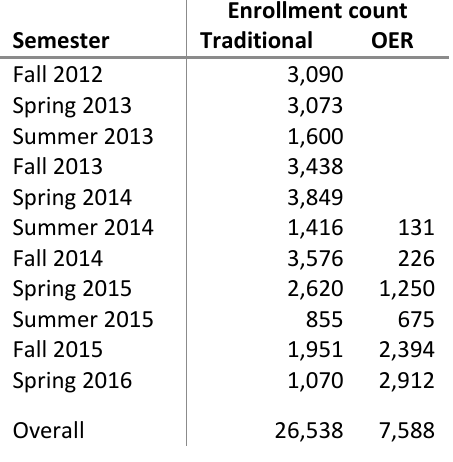
Figure 4. Enrollments included in